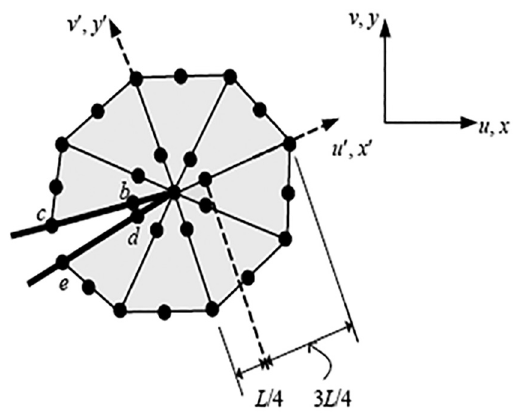
Figure 3: Special elements used for displacement extrapolation